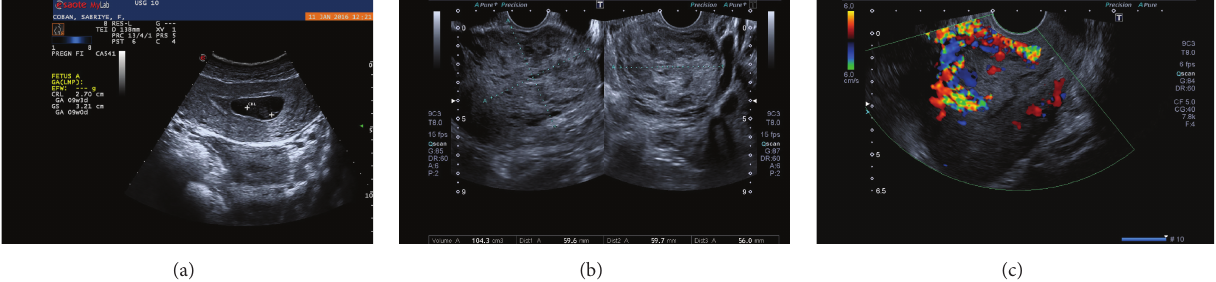
Figure 1: (a) Ultrasound image just before D/C shows 9-week fetus with no cardiac activity and there is no sign of uterine AVM. (b) Sagittal endovaginal image of the uterus shows 60 × 60 × 56 mm (103 cm 3 ) hyperechogenic and heterogeneous mass lesion located in the anterior wall of the uterus and extending laterally at the left. (c) Color Doppler image shows multiple tortuous vessels.